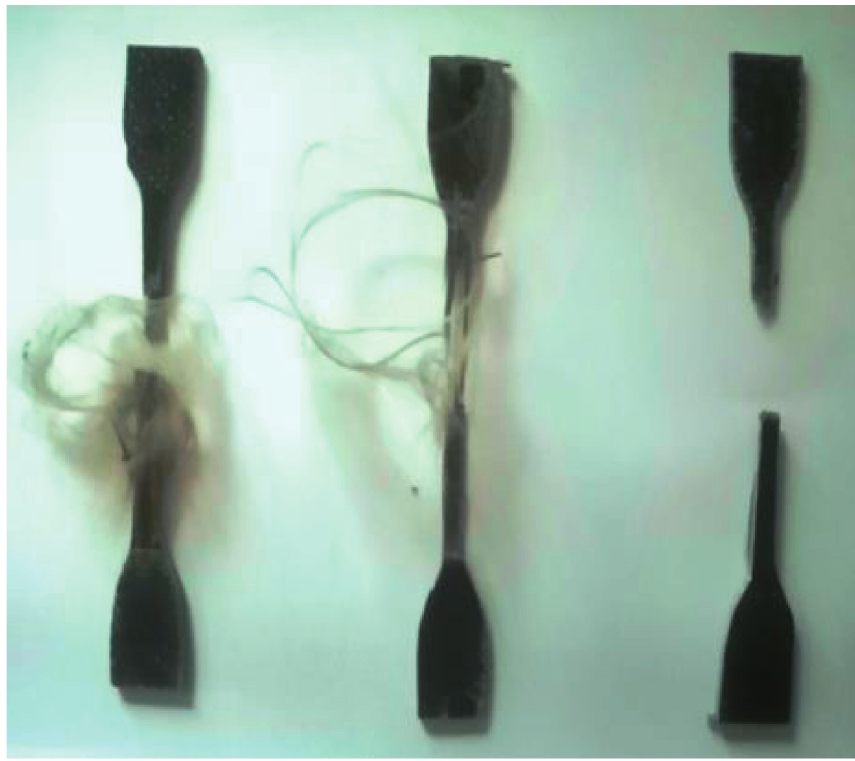
Figure 6: Representations of tensile tested samples for (a) laminate L 1; (b) laminate L 2; (c) laminate L 3.